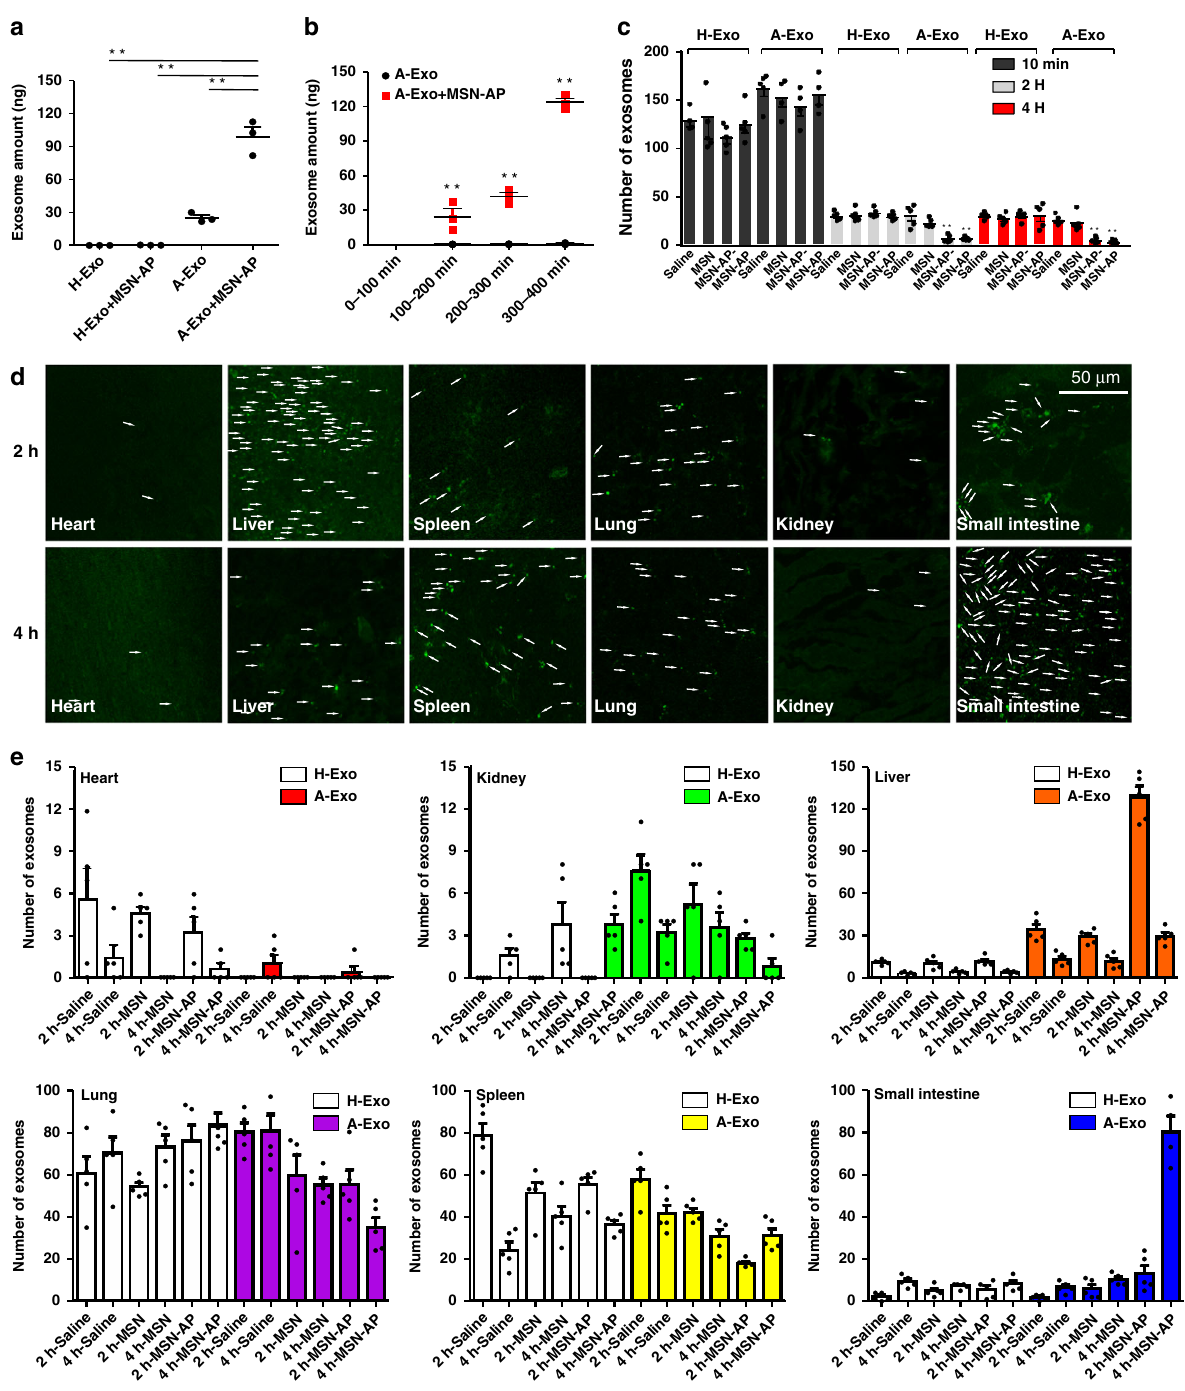
Fig. 5 In vivo conjugation between MSN-AP and A-Exo accelerates hepatobiliary excretion of circulating A-Exo. a Excreted amounts of A-Exo or H-Exo in the small intestines after injection (both 50 µ g) into the portal vein of rats (local injections) with or without MSN-AP injections (5 mg/kg, n = 3 rats). b A- Exo amount in rat bile after injection into the tail vein of rats (system injection) with or without MSN-AP injections. n = 3 rats. c Blood amounts of H-Exo or A-Exo (green PKH67-labelled) after tail vein injection into mice followed by injections of saline, MSN, MSN-AP − and MSN-AP (200 µ l of 5 mg per kg), respectively. n = 5. d Confocal microscopy showing the PHK67-labelled A-Exo distribution (arrows indicate exosome foci) in various mouse tissues followed by MSN-AP injection (see Supplementary Figs. 26 and 27 for MSN, MSN-AP − , MSN-AP treatments). e Quanti fi cation of i.v. A-Exo distribution in tissues following saline, MSN, MSN-AP − , and MSN-AP i.v. administration compared with the H-Exo distribution. Note that the decrease in the A-Exo amount in the liver was followed by its sequential increase in the small intestine. n = 5. Data presented as the mean ± s.e.m. ** P < 0.01; one-way ANOVA ( a ) and unpaired two-tailed t test ( b ). The Y -axis of Fig. 5c, e represents the average number of 4 – 5 randomly selected single fi elds of vision. Source data are provided as a Source Data fi